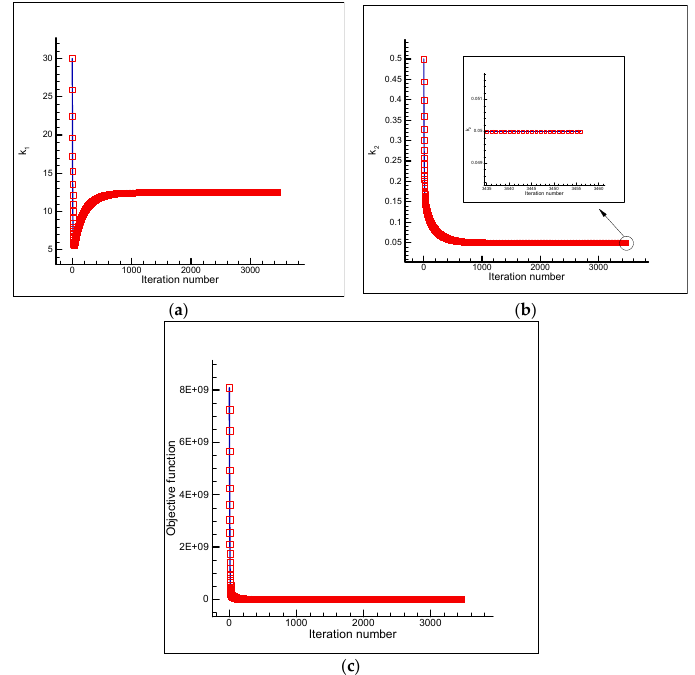
Figure 12. Estimation of k 1 ( a ) and k 2 ( b ), and the objective function versus iteration number ( c ) using = 30.0 + 0.5 T ( W ) and a single sensor placed at the node ( i , j ) = ( 3,12 ) the initial guess k T m. ◦ C initial 1